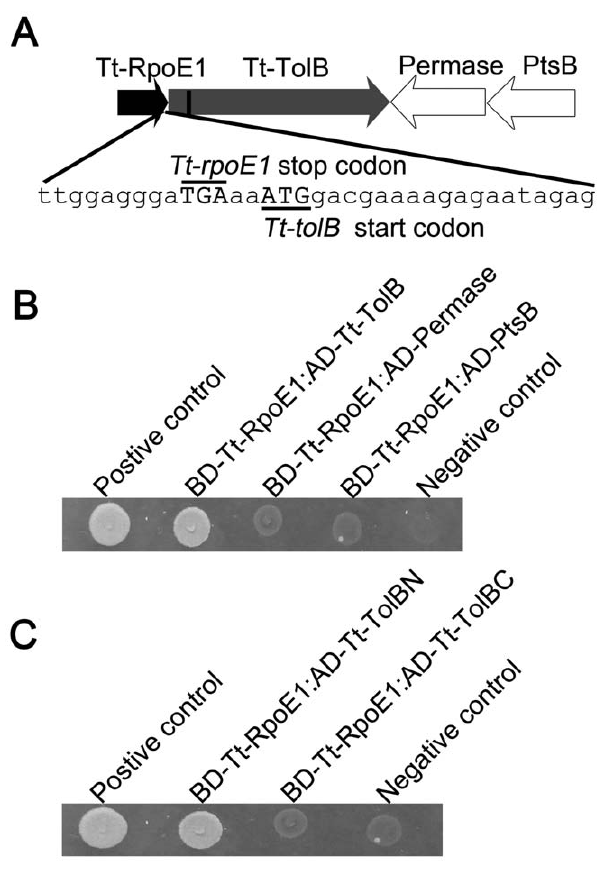
Figure 1. The interaction between T.tengcongensis ECF s factor Tt-RpoE1 and its putative anti- s factor Tt-TolB. ( A ). Organization of the genes encoding Tt-RpoE1, Tt-TolB and two other proteins (Permease and PtsB). The vertical black line in Tt-TolB indicates the predicted membrane-spanning domain. Partial sequence including the stop codon of Tt-rpoE1 and the start codon of Tt-tolB is shown. ( B ). Y2H analysis of the interaction between Tt-RpoE1 and Tt-TolB and between Tt-RpoE1 and the other two proteins. ( C ). The interaction between Tt- RpoE1 and the N-terminal or the C-terminal region of Tt-TolB.